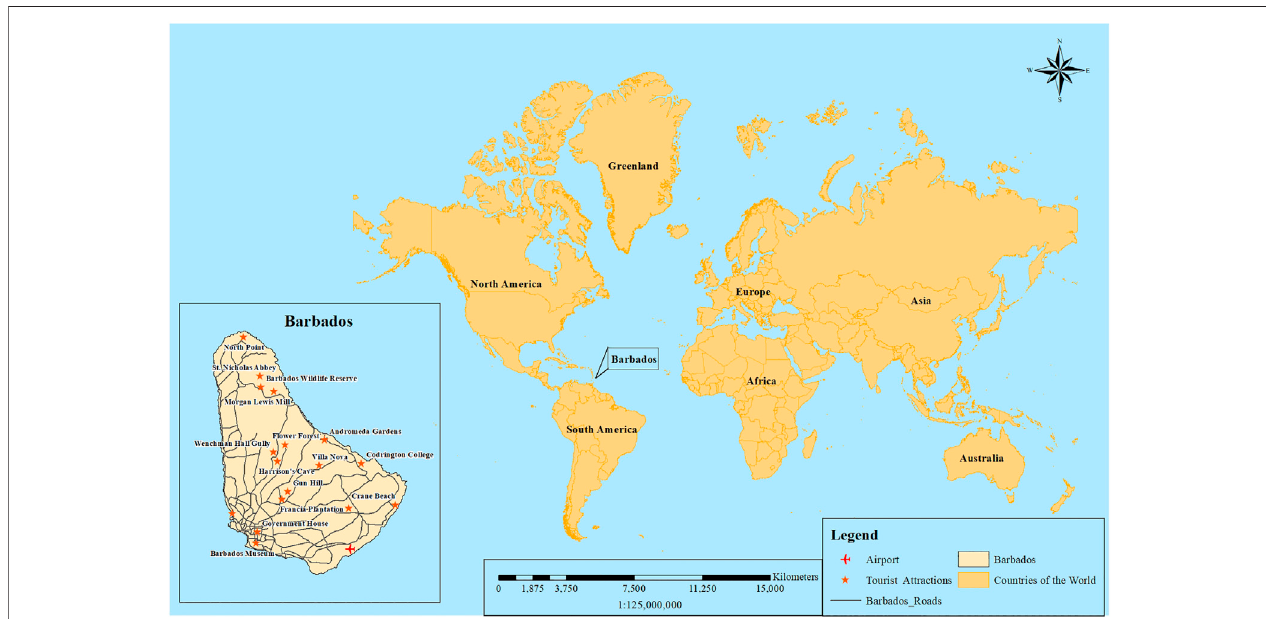
FIGURE 1 | Map of Barbados in relation to major geographical regions of the world (source: Rajesh Doodlal).